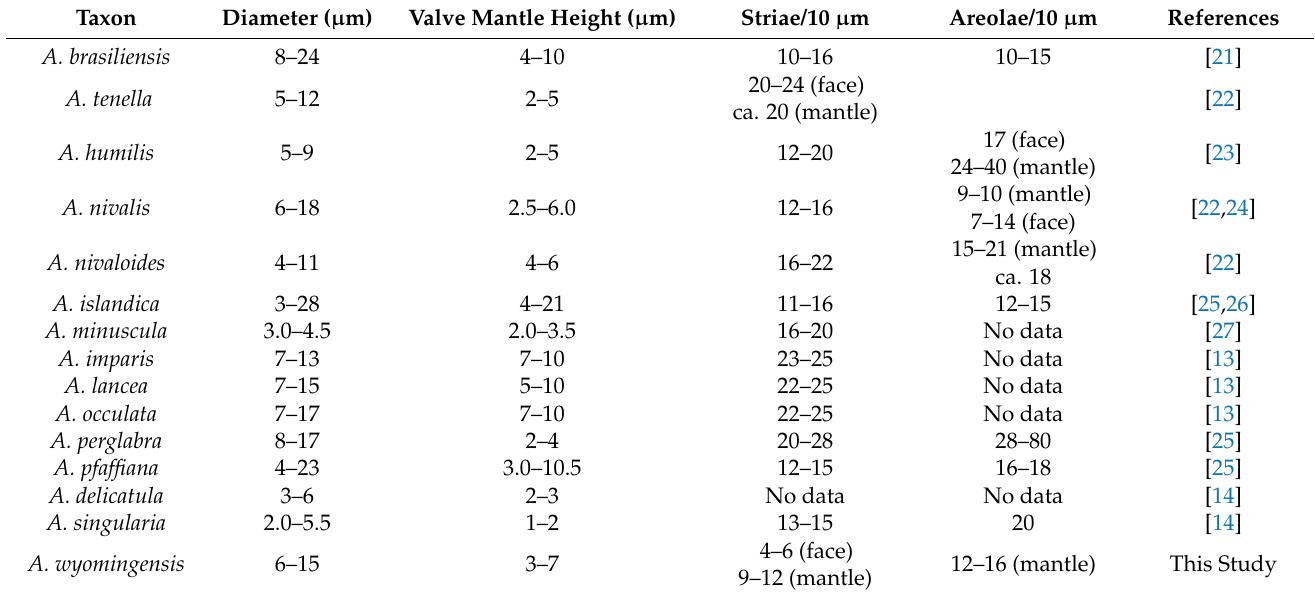
Table 1. Comparison of morphometric data of some Aulacoseira species with valve face covered with